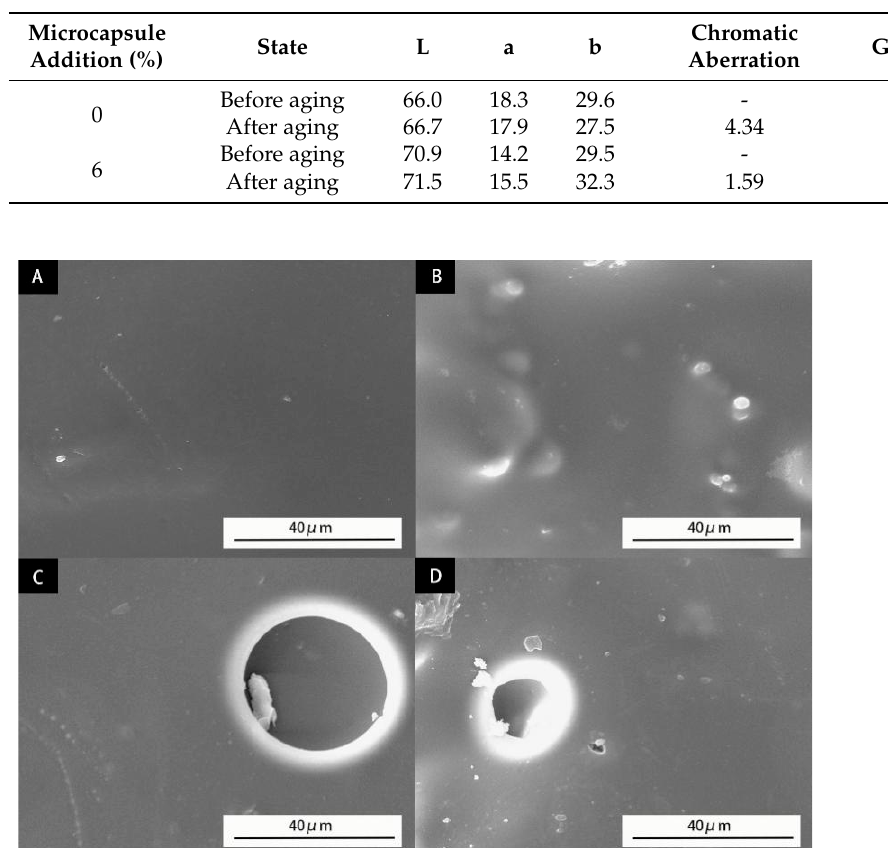
Figure 11. SEM of waterborne primer coating with different content of microcapsules before and after aging; before aging: ( A ) 0% of the microcapsule, ( B ) 6% of microcapsule; after aging: ( C ) 0% of the microcapsule, ( D ) 6% of the microcapsule.